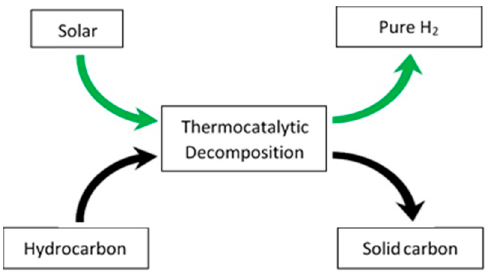
Figure 1. Inputs and outputs of TCD.